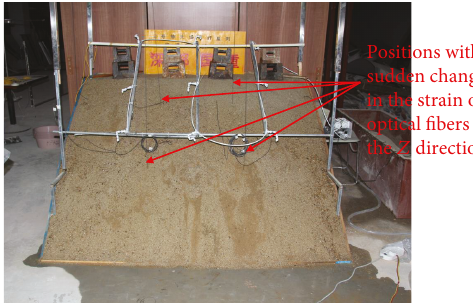
Figure 15: Locations of sudden change in the strain of optical fi bers in the Z